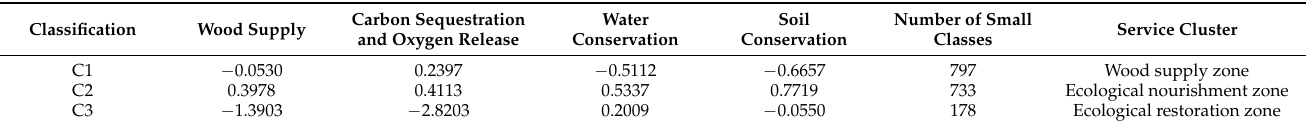
Table 5. Difference between the ES clusters in the northern tropical case study area of PM plantation forests and the mean value of each service in the whole study